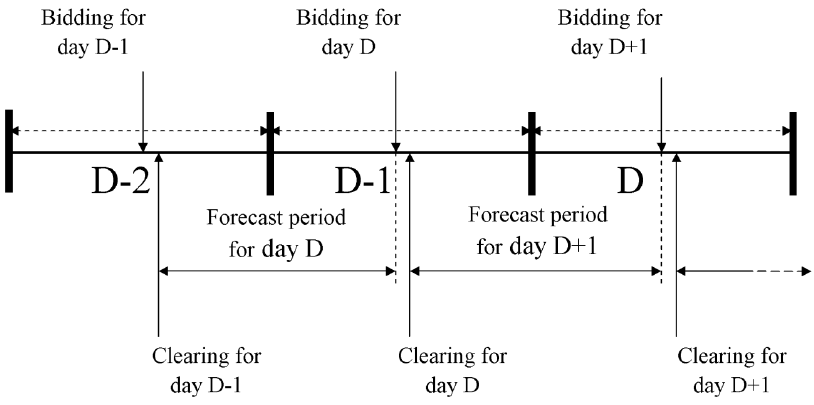
Figure 3. Time framework to forecast market prices for the Nordic day-ahead energy